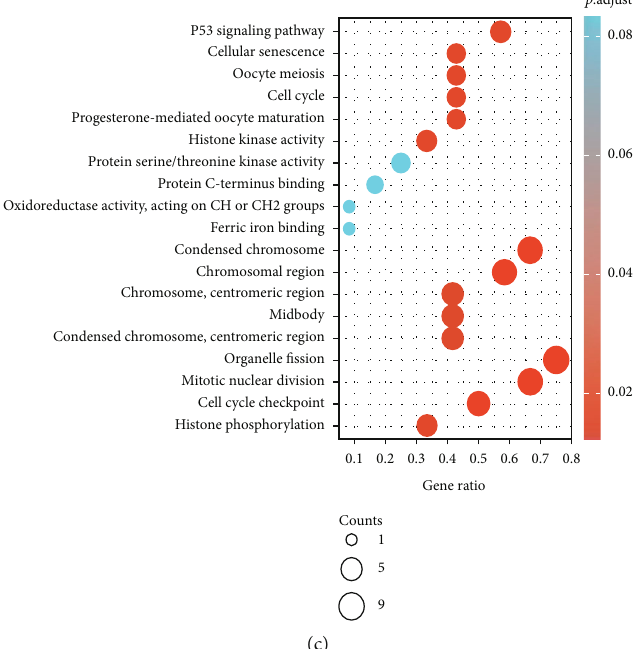
Figure 3: Download the hub gene from the DAIVED website (https://david.ncifcrf.gov/), and then, use the ggplot2 package and clusterPro fi ler package in the R language to visualize the enrichment analysis of GO and KEGG. Panel (a) is the enrichment analysis of upregulated genes, and panel (b) is the enrichment analysis of downregulated genes. Panel (c) is the visualization diagram of the enrichment analysis of the hub